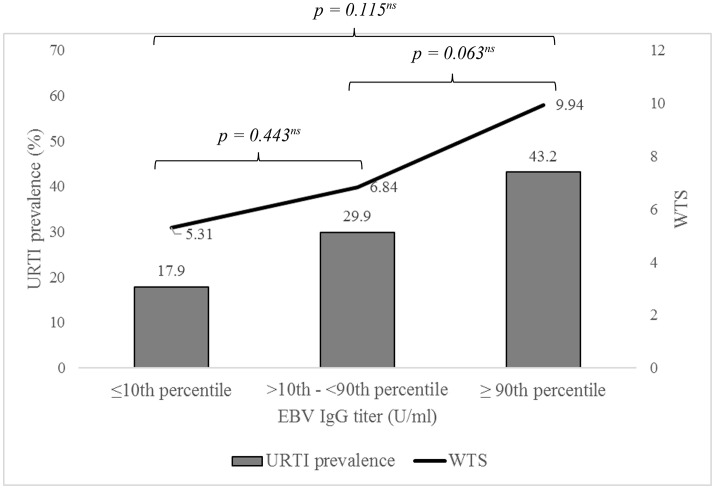
URTI prevalence and WURSS-21 total score (WTS) depending on EBV-specific IgG titers categorized in different percentiles (≤10th percentile: ≤51 U/ml, >10th-<90th: >51-<268 U/ml, ≥90th: ≥268 U/ml). Values are expressed as means.